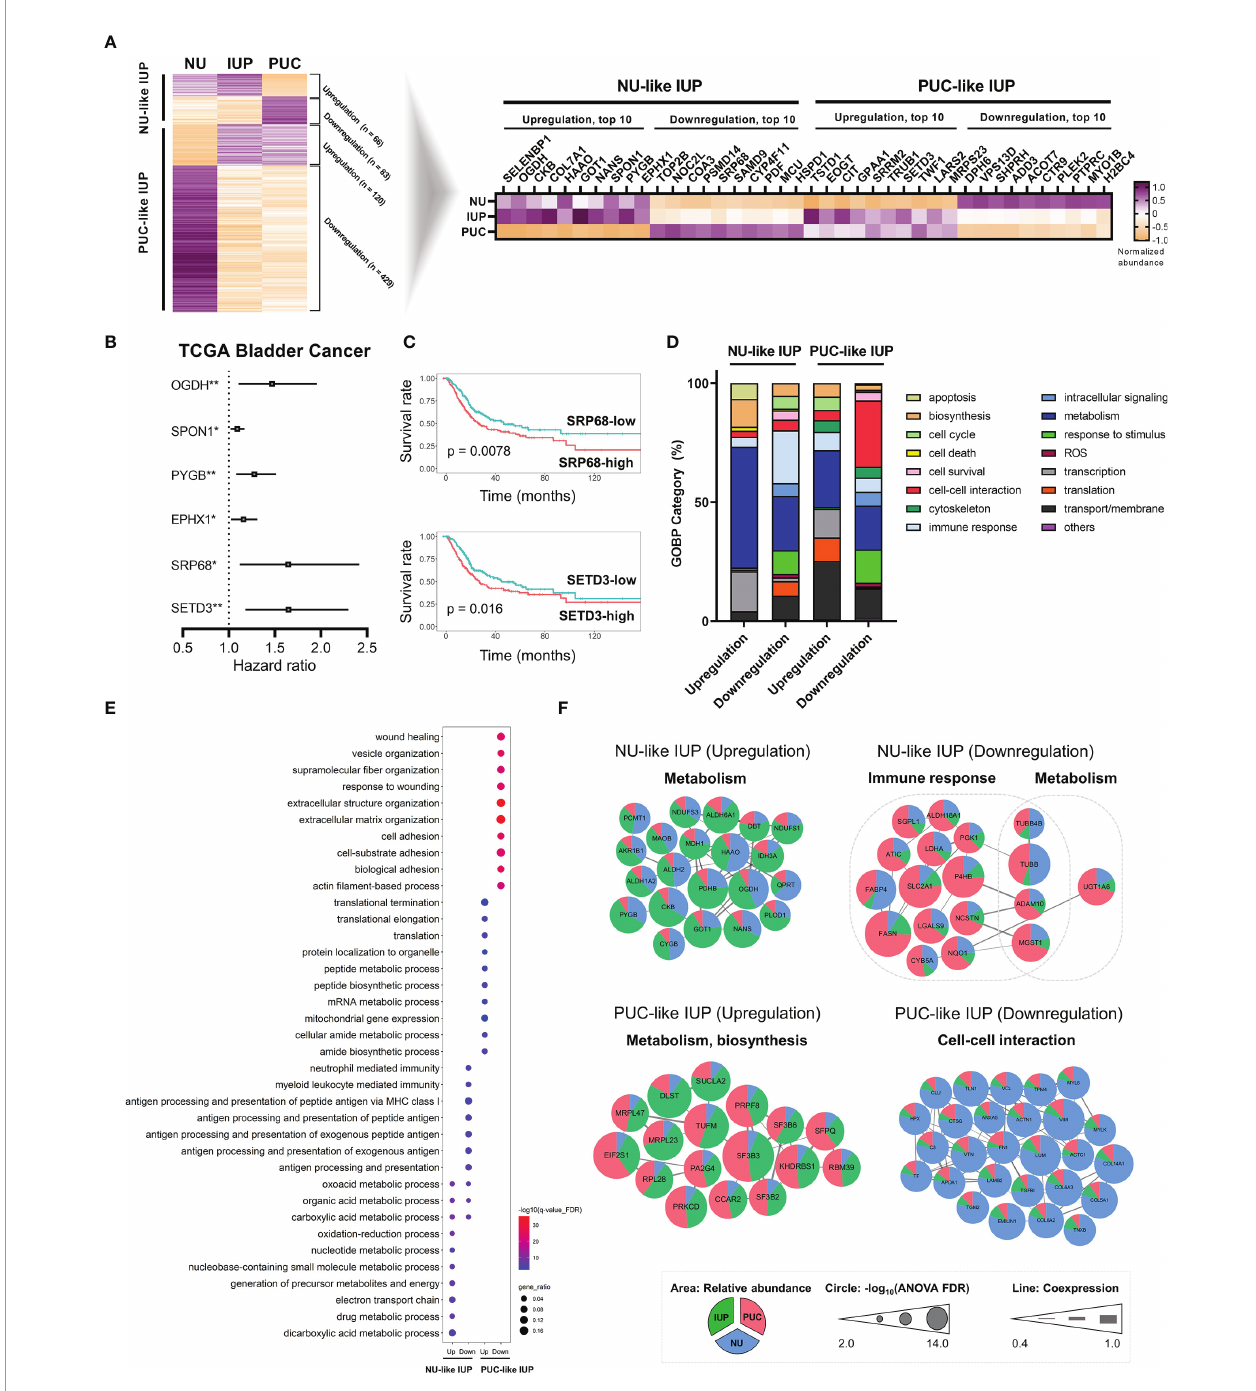
FIGURE 1 | Proteomics-based oncologic signatures of inverted urothelial papilloma (IUP). (A) ‘ Papillary urothelial carcinoma (PUC)-like ’ IUP and ‘ normal urothelium (NU)- like ’ IUP signatures selected from the ANOVA-based differentially expressed proteins (left). The 40 top-ranked proteins of each signature are summarized (right). (B) Hazard ratios with 95% con fi dence intervals of the signi fi cant univariate Cox analysis results of the 40 proteins in the TCGA bladder cancer (BLCA) dataset. (*p < 0.05, **p < 0.01). (C) Kaplan – Meier graphs of SRP68 and SETD3 in the TCGA BLCA dataset. (D) Distribution of Gene Ontology-Biologic Process (GOBP) categories enriched in the upregulated and downregulated proteomes of ‘ NU-like ’ IUP and ‘ PUC-like ’ IUP signatures. (E) The top 10 signi fi cantly associated GOBPs. (F) Protein – protein interaction networks of the proteomes included in the top 10 signi fi cant GOBPs and their related functions. Unconnected proteins are not